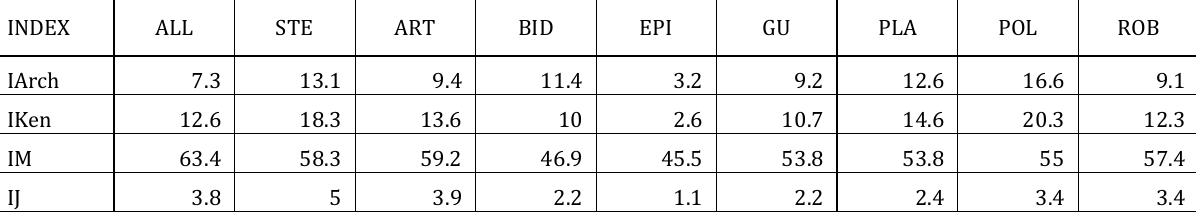
Table 3. Indices of archaeophytization, kenophytization, modernization and fluctuation of ruderal phytocoenoses of Ukraine INDEX ALL